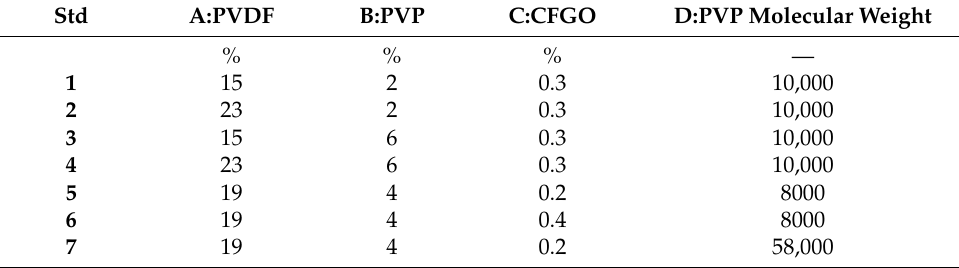
Table 2. BBD response surface design of